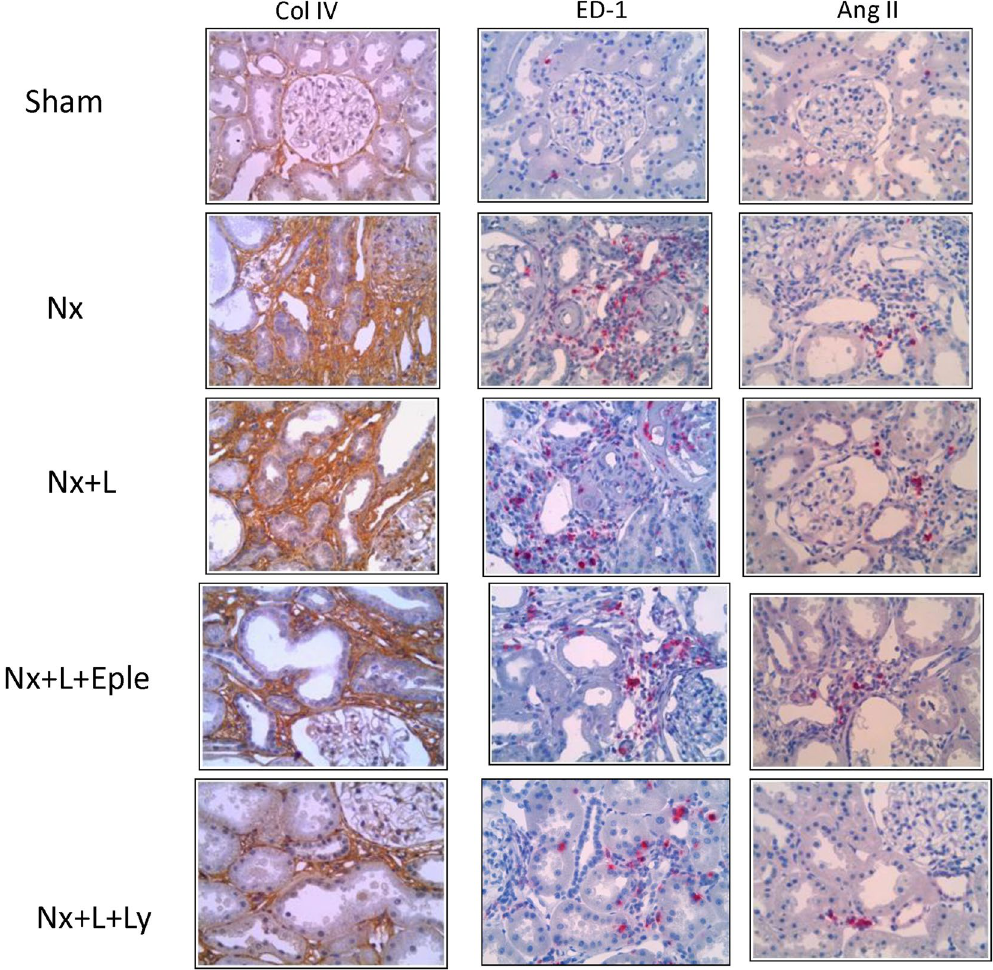
Figure 8. Representative photomicrographs of renal tissue stained by immunohistochemistry for collagen I, macrophages and AngII- + cells in the five groups studied in Protocol 2